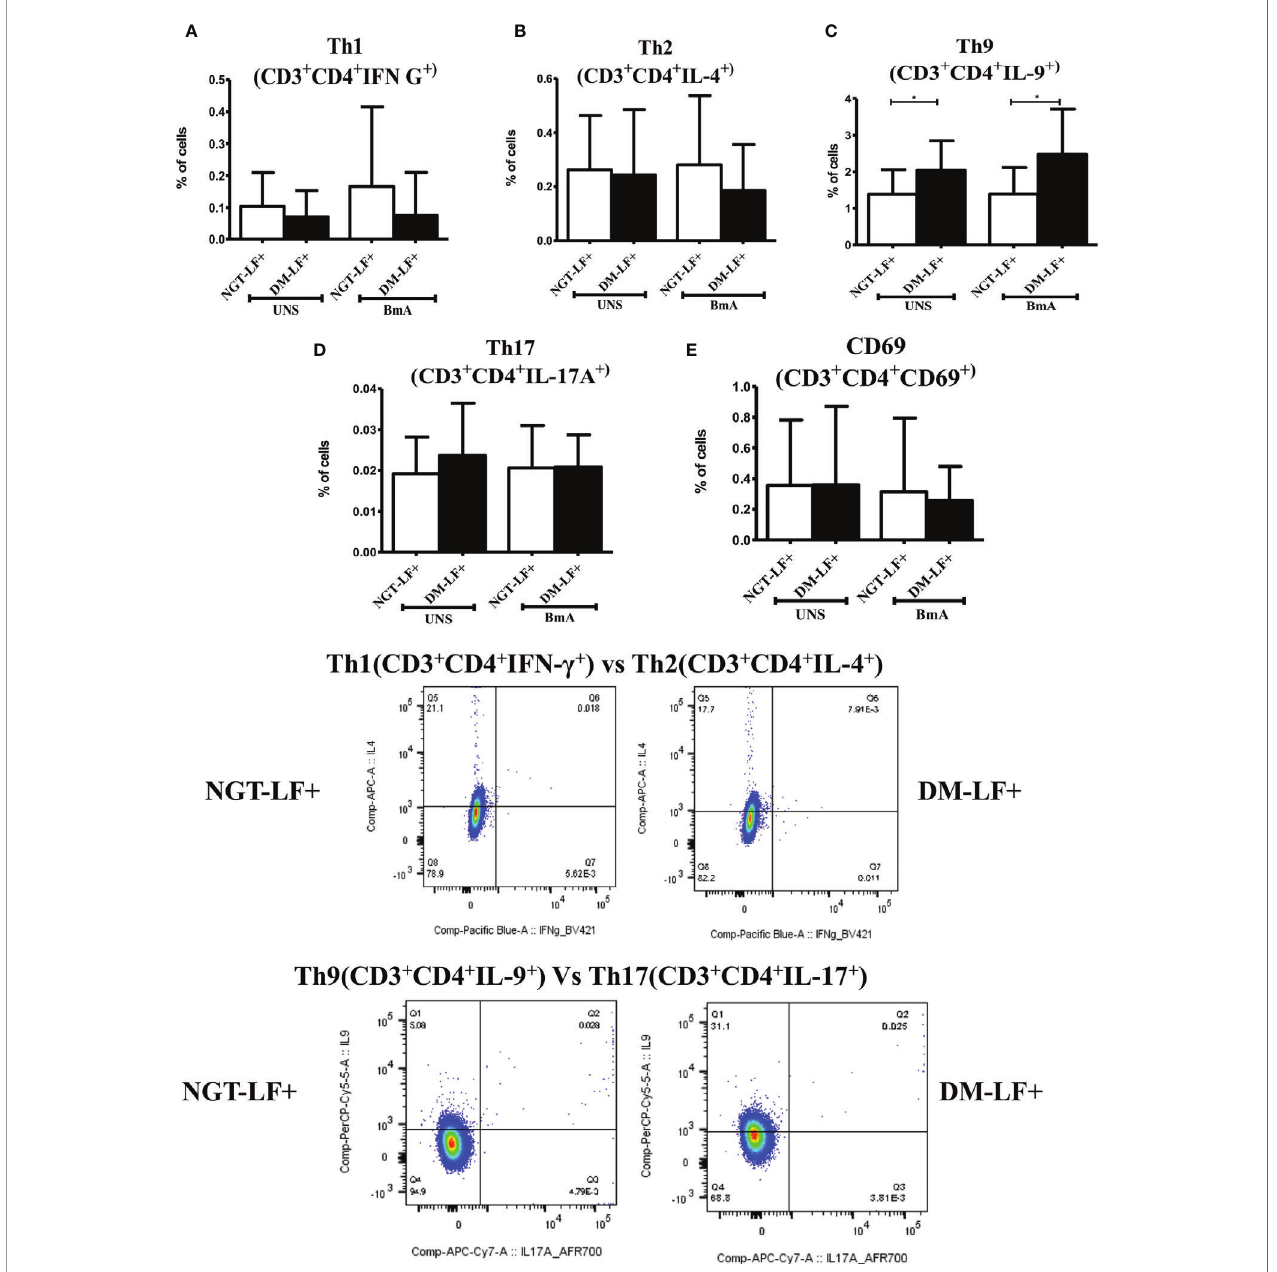
FIGURE 6 | Effect of diabetes on T-cell activation and Th polarization in LF+ subjects. Bar graph showing Unstimulated (UNS) and fi larial antigen (BmA)-induced Th1 (A) , Th2 (B) , Th9 (C) , Th17 (D) , and activated T cells (E) in NGT-LF+ and DM-LF+ subjects. Statistical signi fi cance was determined by non-parametric Mann – Whitney U test and p < 0.05 was considered signi fi cant. * p <